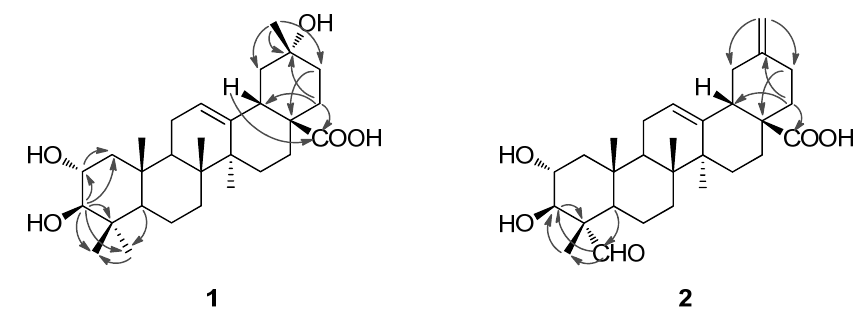
Figure 3. Selected HMBC correlations of compounds 1 and 2